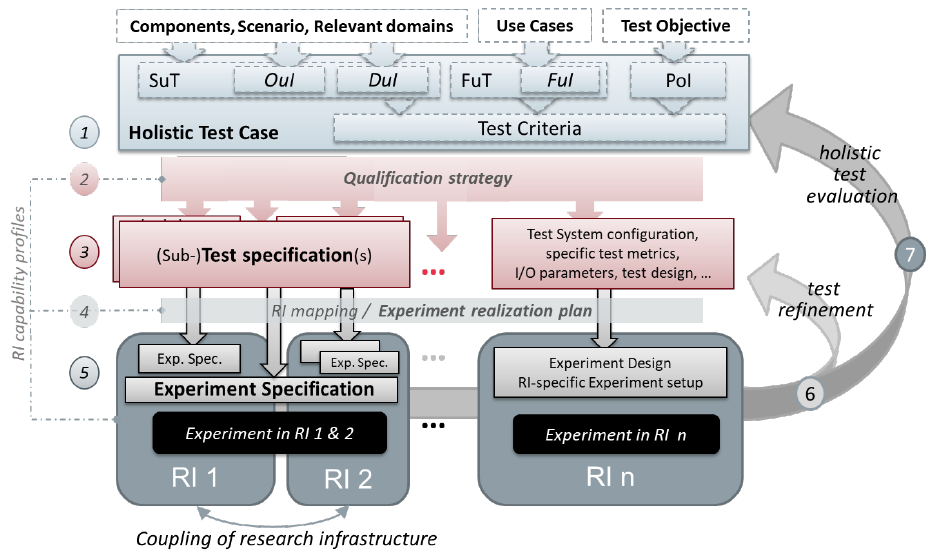
Figure 3. Overview of ERIGrid Holistic Test Procedure with test description elements. In focus of this guideline are test description elements 1–5 (Section 3.1) [7,17].